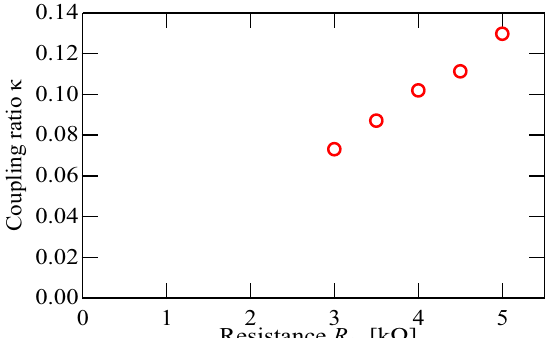
Figure 6. Relationship between the experimentally measured coupling ratio κ and the resistance R c used to tune the nominal coupling ratio. The experimentally measured coupling ratio was proportional to the resistance R c . Setting the resistance R c smaller achieves a smaller coupling ratio, and a smaller coupling ratio κ will produce a higher sensitivity.